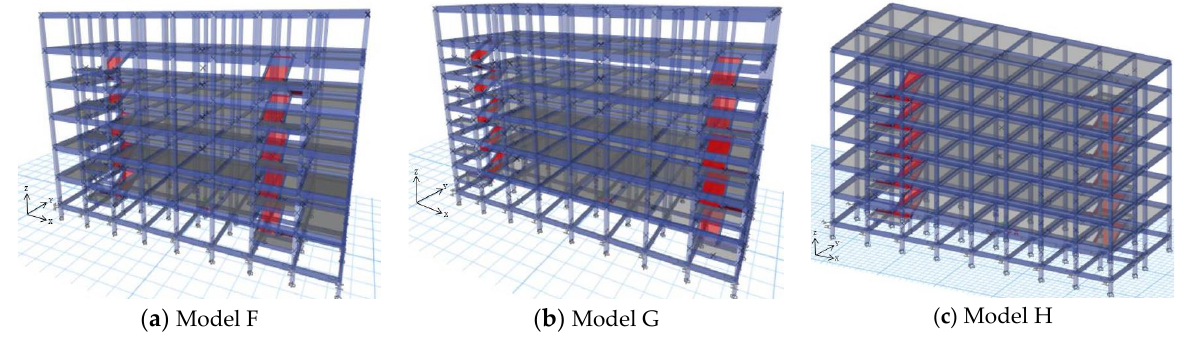
Figure 7. The models of three different staircase positions.